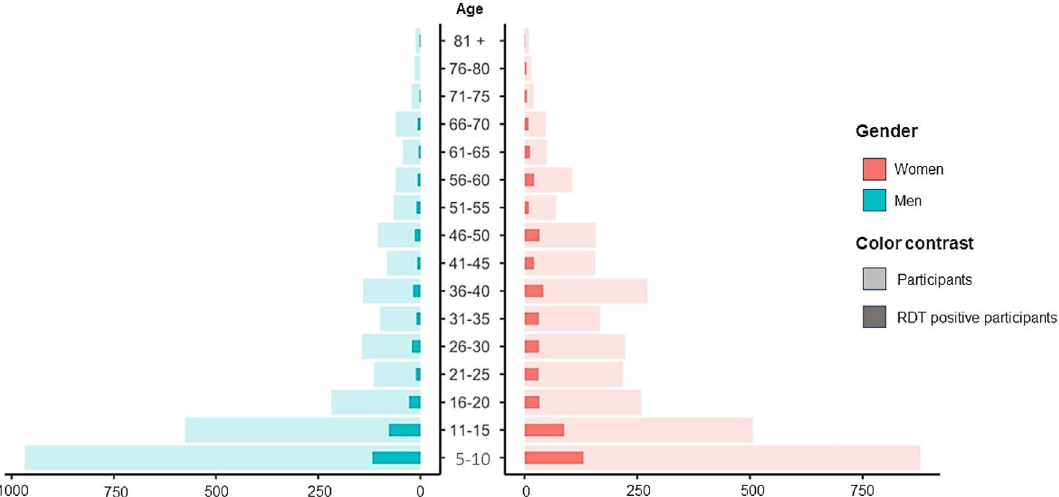
Figure 2. Population age pyramid representing the age and gender distribution of the study population, and the frequency of overall rapid diagnostic test positivity in each age and gender stratum.